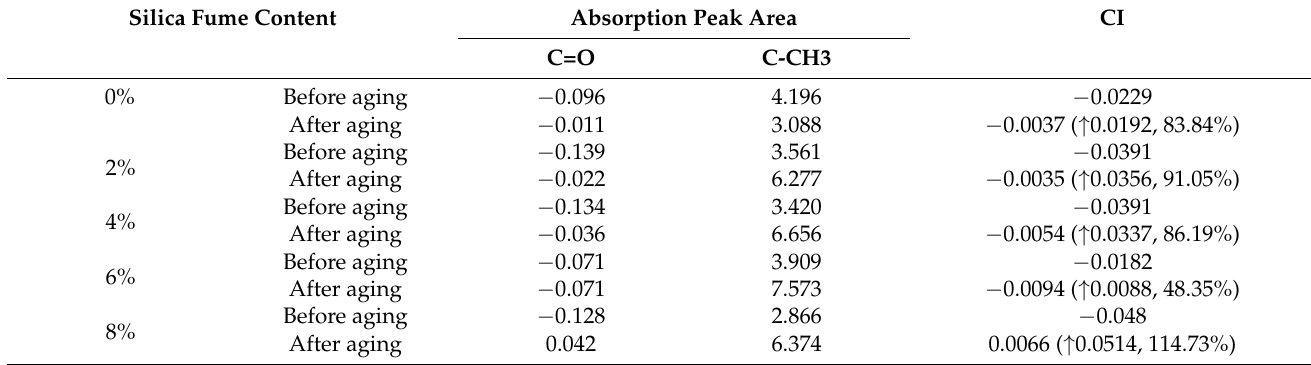
Table 7. Absorption peak area and carbonyl index of composite-modified asphalt before and after